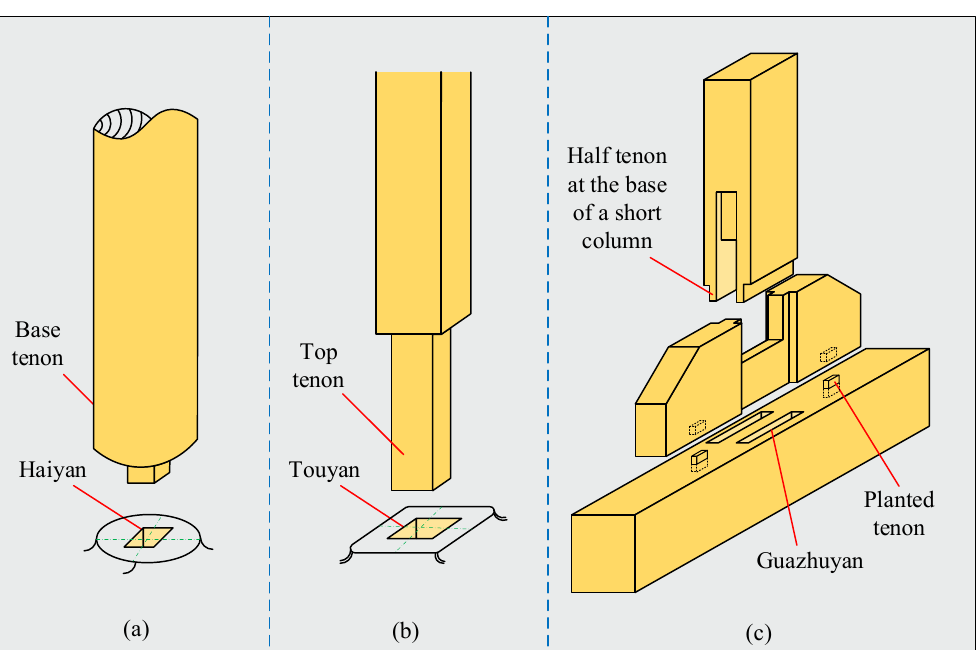
Figure 4. Tenon–mortise joints for fixing vertical structural components. ( a ) Base tenon; ( b ) Top tenon; ( c ) Half tenon at the base of a short column.